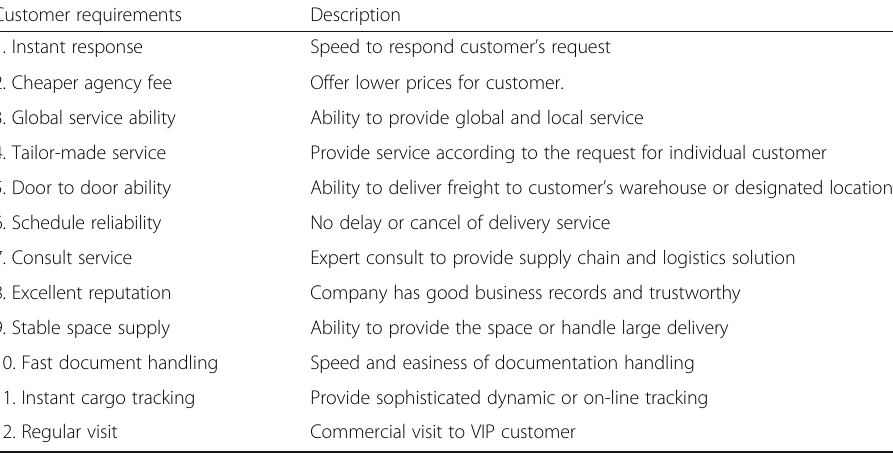
Table 1 Customer requirements in the empirical work Customer